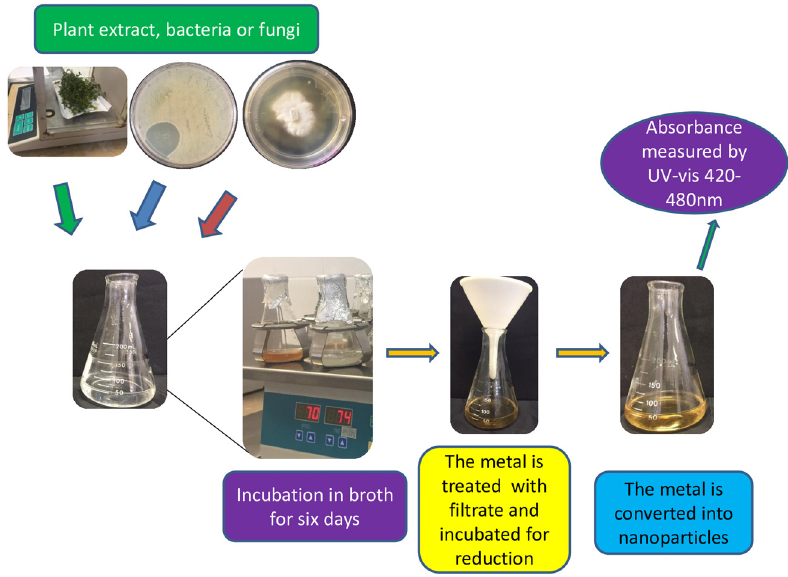
Figure 1: Biosynthesis of nanofertilizers.